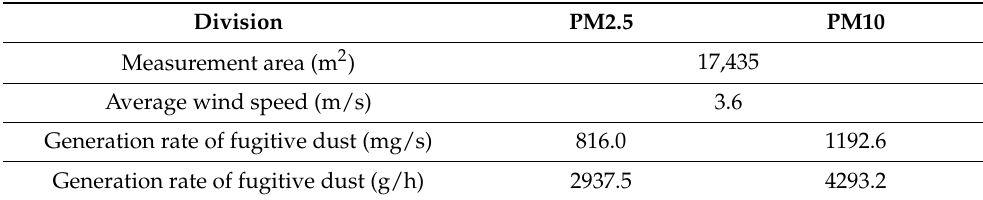
Table 1. Calculated fugitive dust generation rates for different dust size